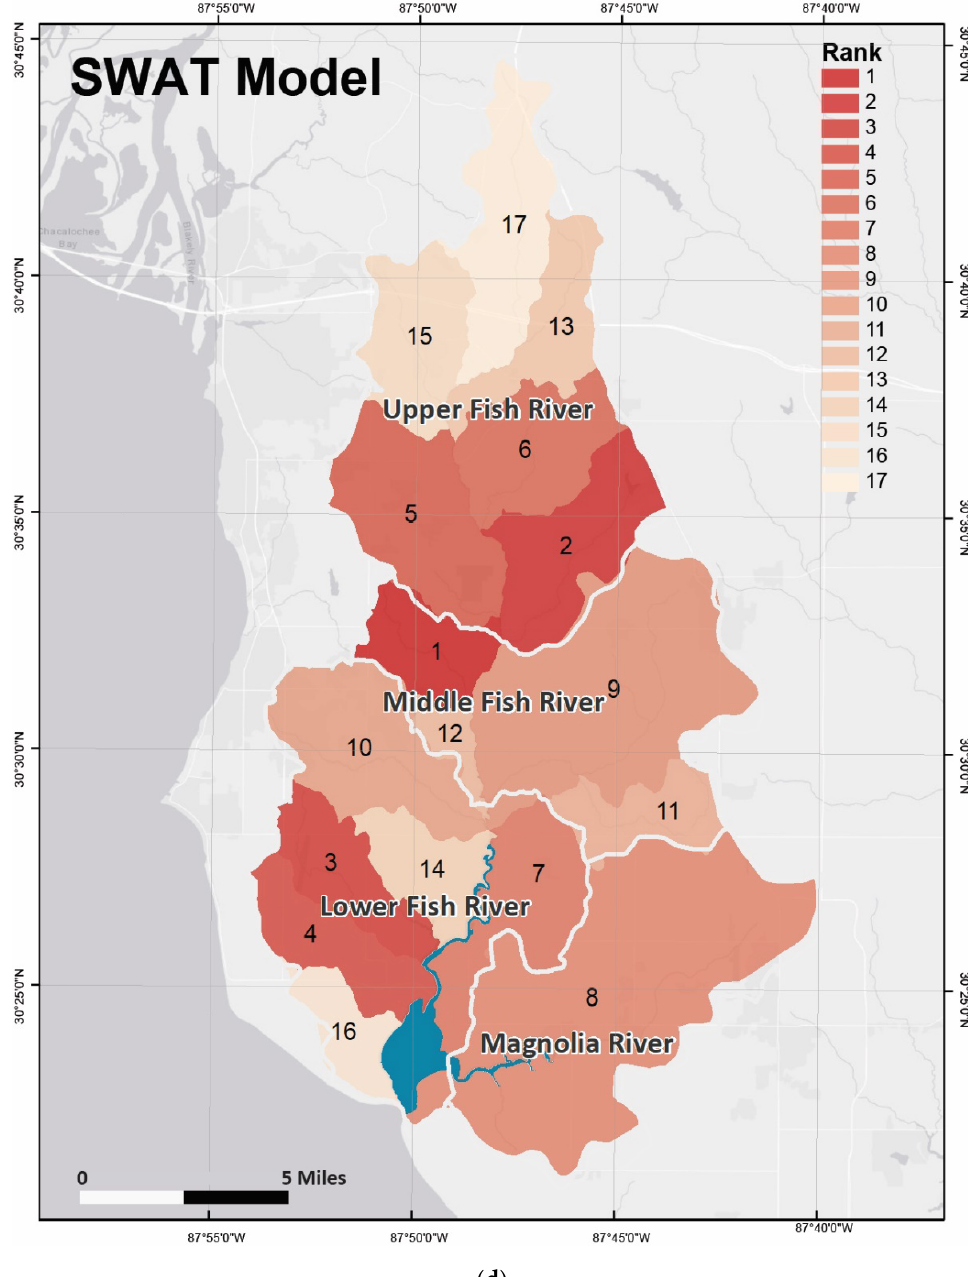
Figure 6. Management area rankings for the WLC ( a ), AHP ( b ), ensembled ( c ), and mapped erosion cells compared with SWAT sediment yield ( d ). Agreement of the rankings in upper ranks provides prioritization of management areas for the Weeks Bay watershed.